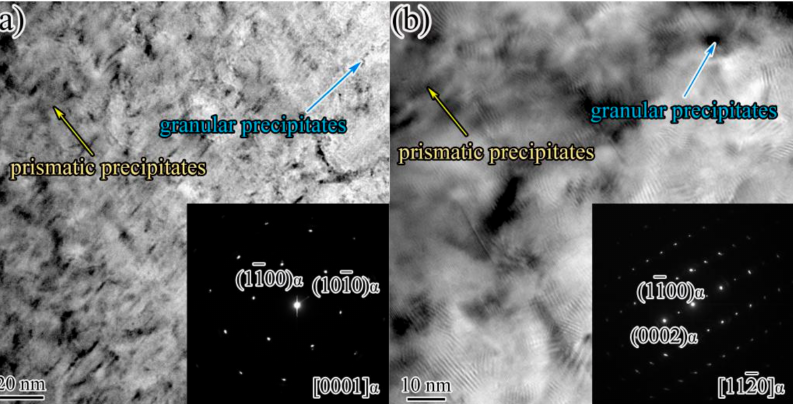
Figure 6. The TEM micrographs and SAED patterns of the IEECAPed and subsequently aged Mg- 2.5Nd-2.0Sm-0.4Zn-0.4Zr. ( a ) TEM micrograph and SAED patterns along [0001] α zone axis of the alloy; ( b ) TEM micrograph and SAED patterns along [1120] α zone axis of the